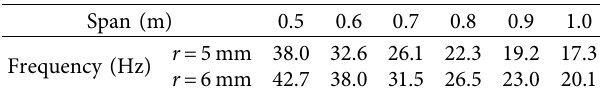
Figure 9: The first-order frequency of the FATMD with different spans ( r � 6mm). Table 1: First-order frequency of the FATMD at different